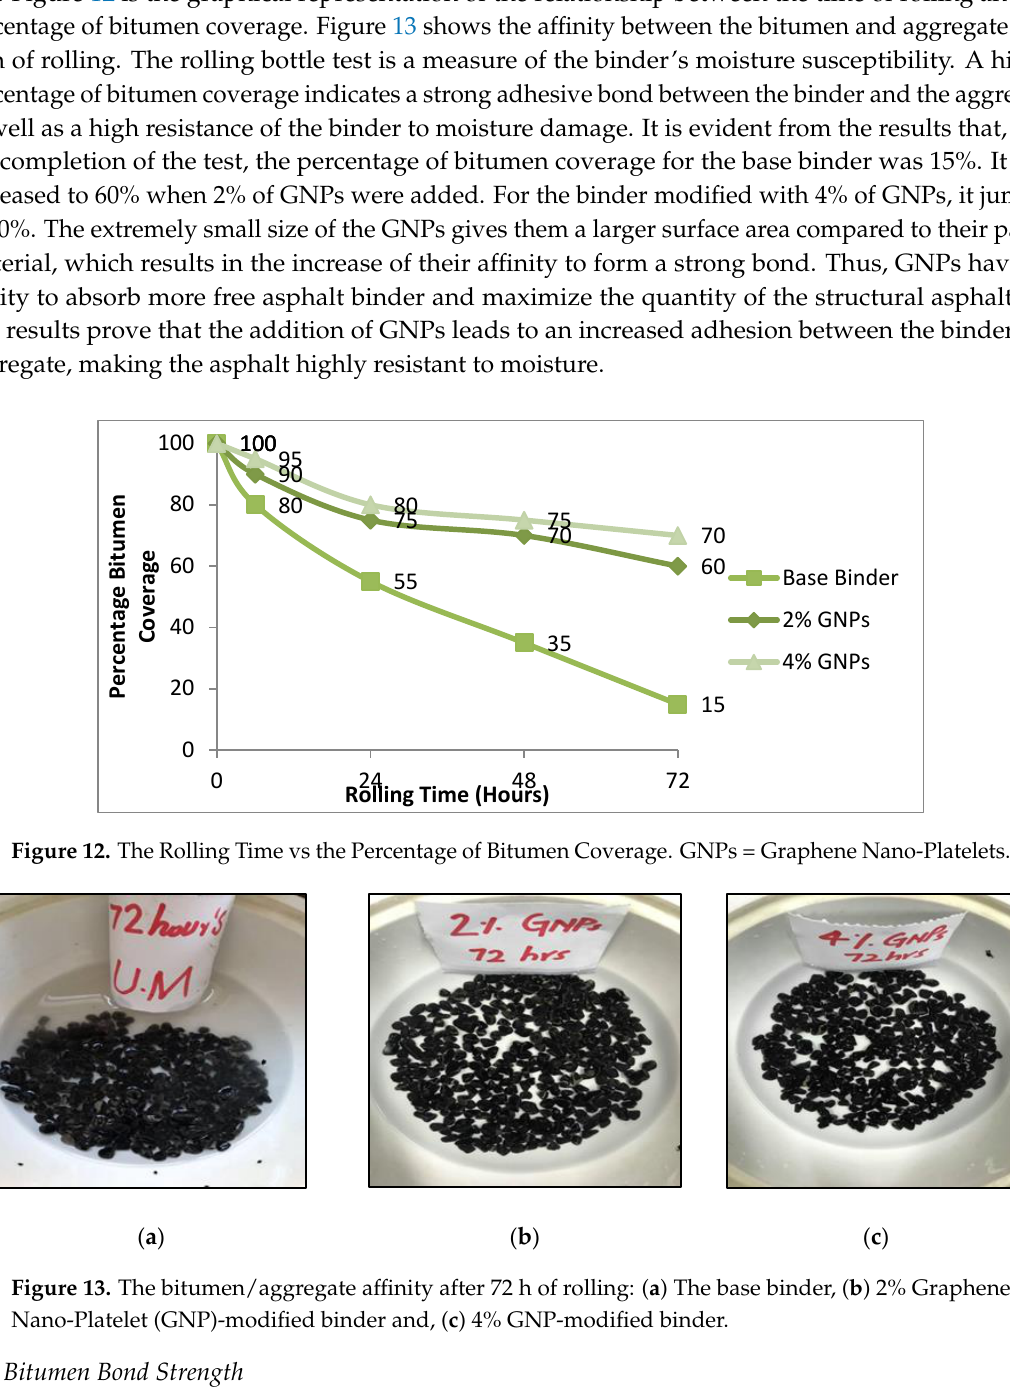
Figure 11. The Dynamic Modulus at 55 °C. GNPs = Graphene Nano-Platelets.